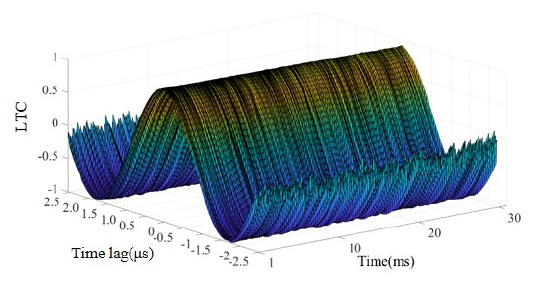
Figure 6. Local temporal coherence ( LTC) of example signal.